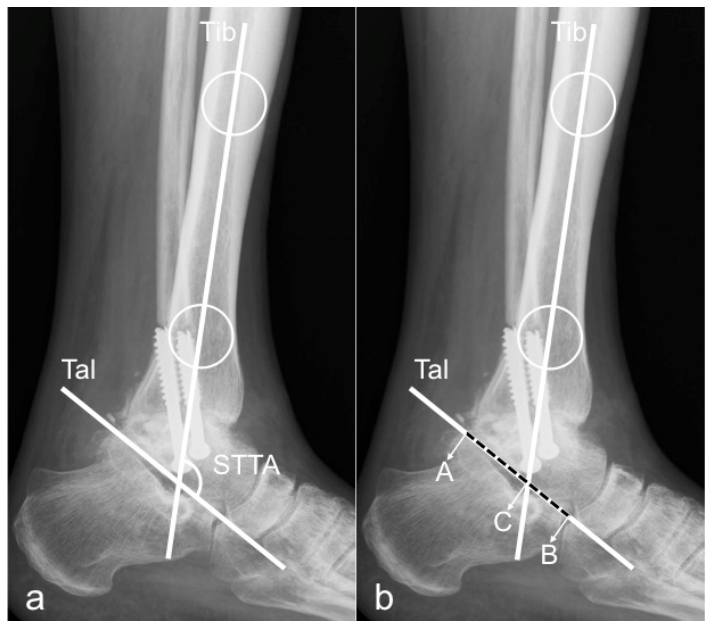
Figure 1. Method 1 for STTA and mTT-ratio measurement. Lateral ankle radiograph demonstrating Method 1: Tib = longitudinal axis of the tibia, created by connecting two points in the middle of the proximal and distal tibial shaft. Tal = axis of the talus, defined by a line drawn from the inferior aspect of the posterior tubercle of the talus to the most inferior aspect of the talar neck. Figure ( a ) depicts measurement of the sagittal tibio-talar angle (STTA). Figure ( b ) shows measurement of the modified tibio-talar (mT-T) ratio. J. Clin. Med. 2020 , 9 , x FOR PEER REVIEW